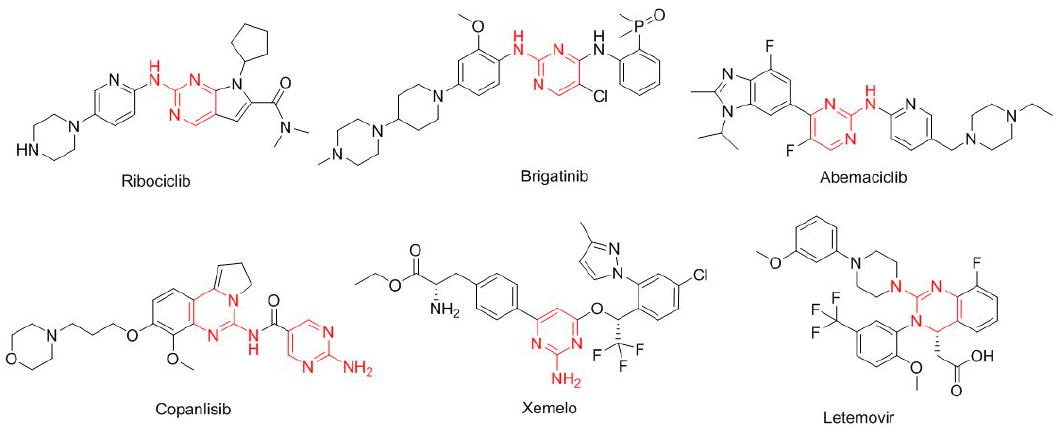
Figure 6. Structure of drugs that contain the 2-amine-pyrimidine (in red) moiety. Enasidenib (Idhifa TM ) is built on a triazine scaffold (Figure 7), which is also present in other drugs, and is indicated for IDH2-positive acute myeloid leukemia.